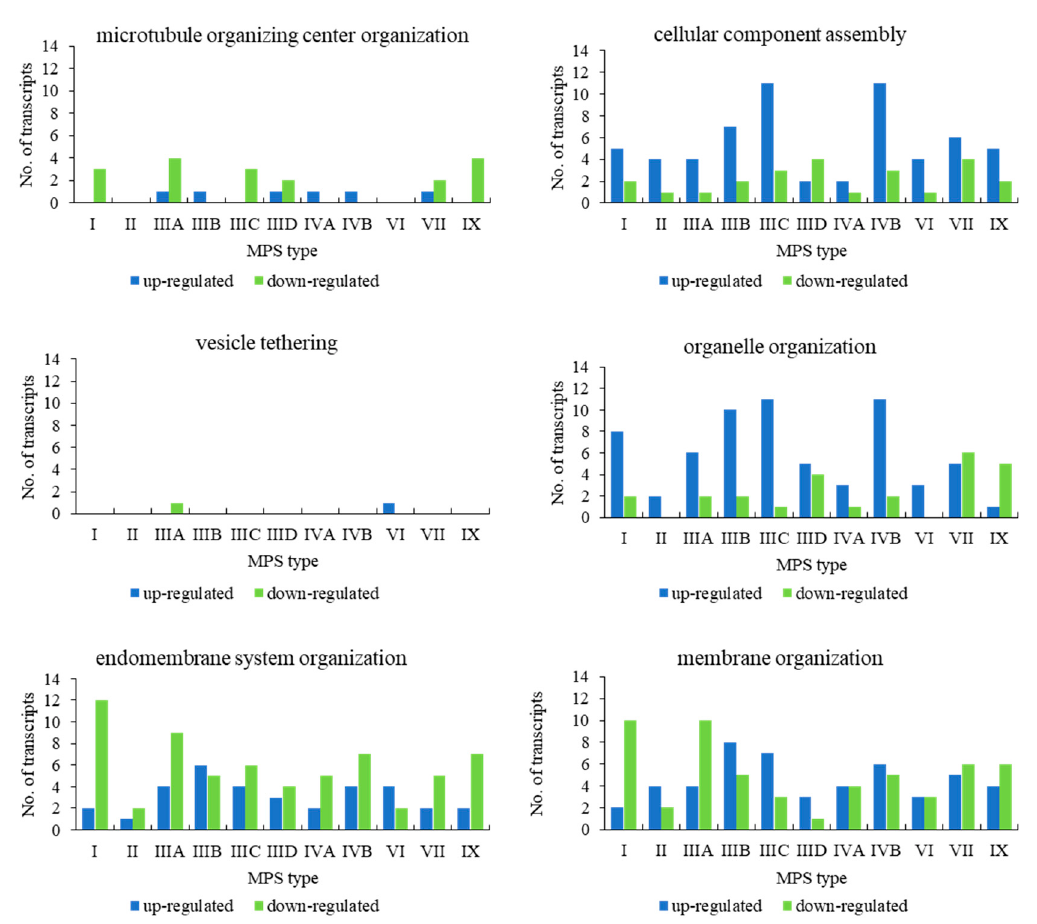
Figure 2. Number of up- and downregulated transcripts (at FDR < 0.1; p < 0.1) with division into selected processes (child terms of ‘cellular component organization’) in different MPS types relative to control cells (HDFa).